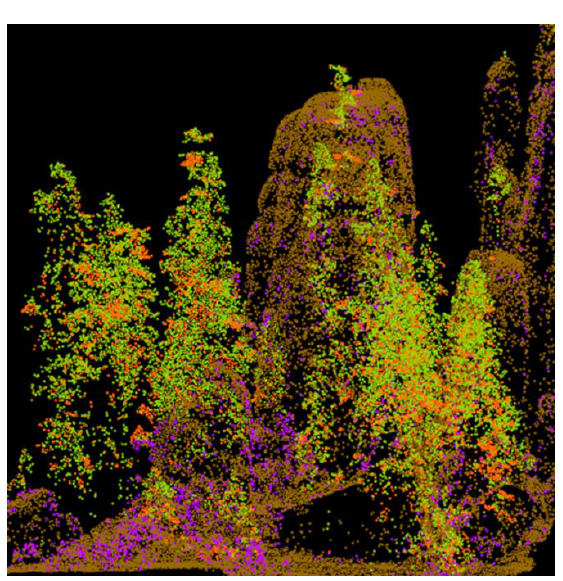
Figure 5. 3D view of a part of testing data. Brown and green dots remark correctly classified ground and non-ground points, orange dots are misclassifie d non-ground and purple misclassified ground